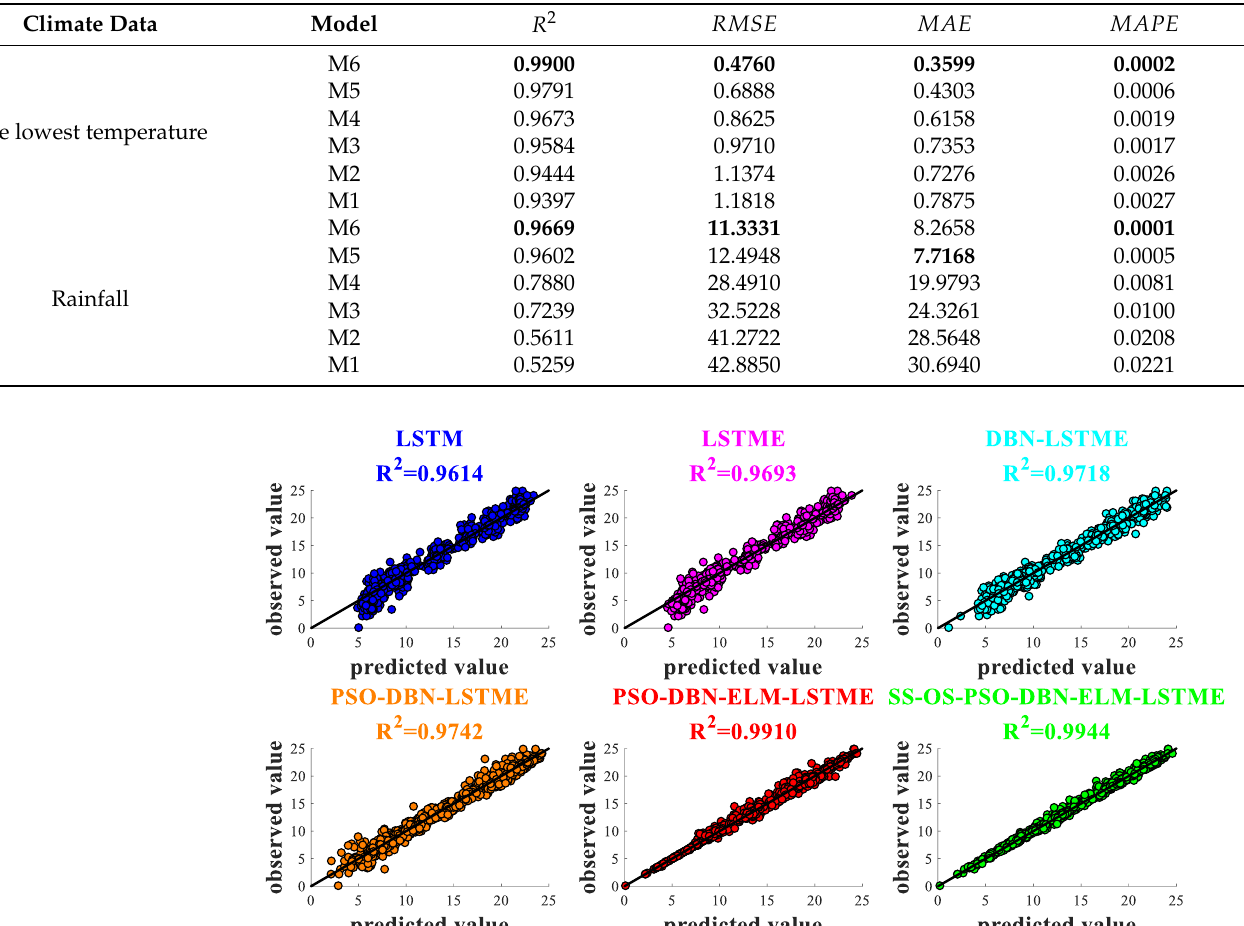
Figure 10. Scatter plots of observed and predicted highest temperature (unit: °C) using M1 − M6 models.